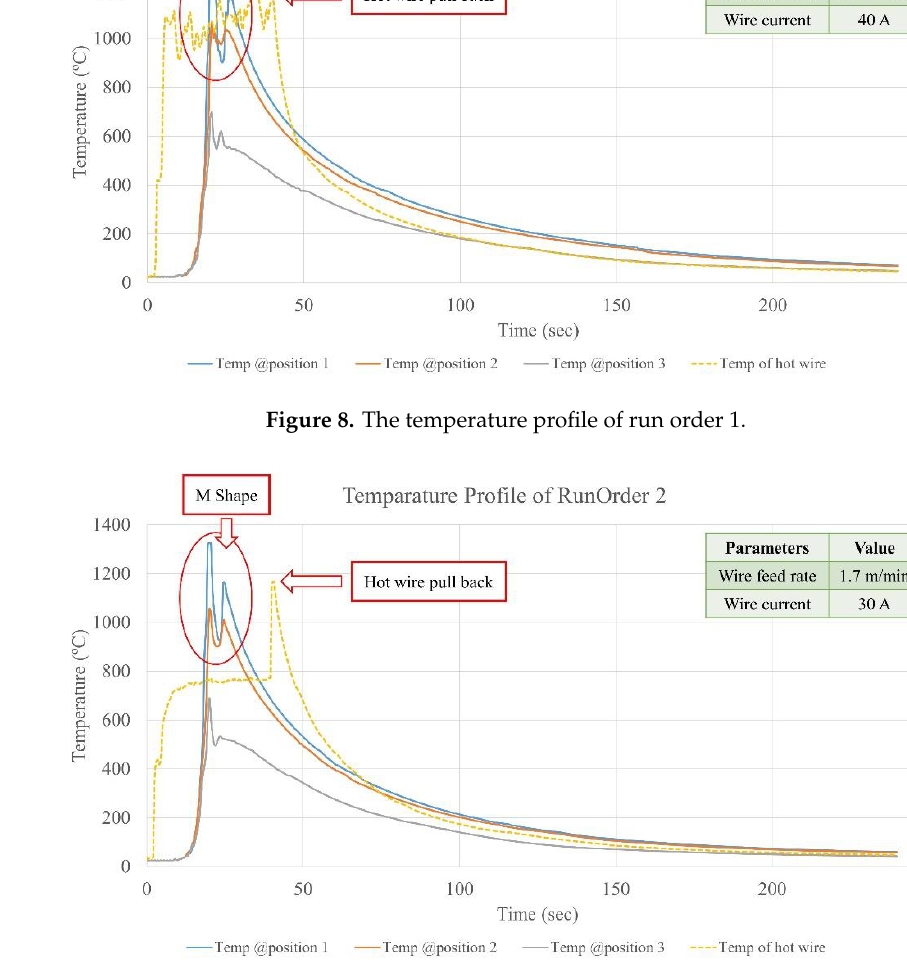
Figure 9. The temperature profile of run order 2.